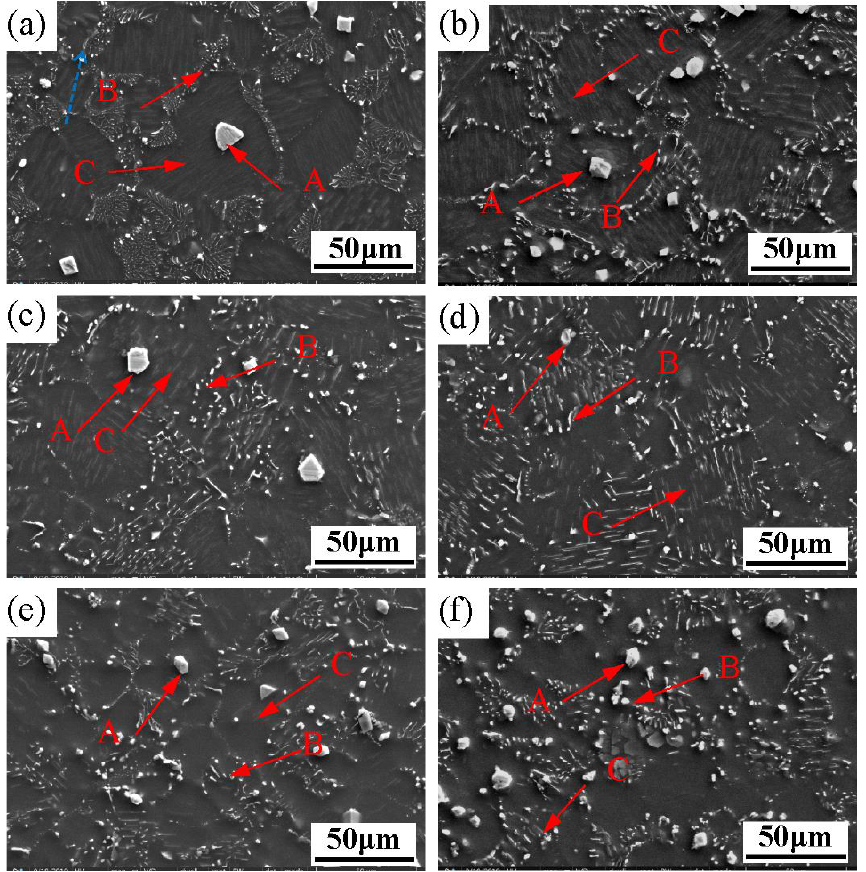
Figure 4. SEM images of the Mg-3Y-4Nd-2Al alloy after solution at 545 °C for different time periods: ( a ) 2 h, ( b ) 4 h; ( c ) 8 h, ( d ) 16 h, ( e ) 24 h, and ( f ) 48 h.